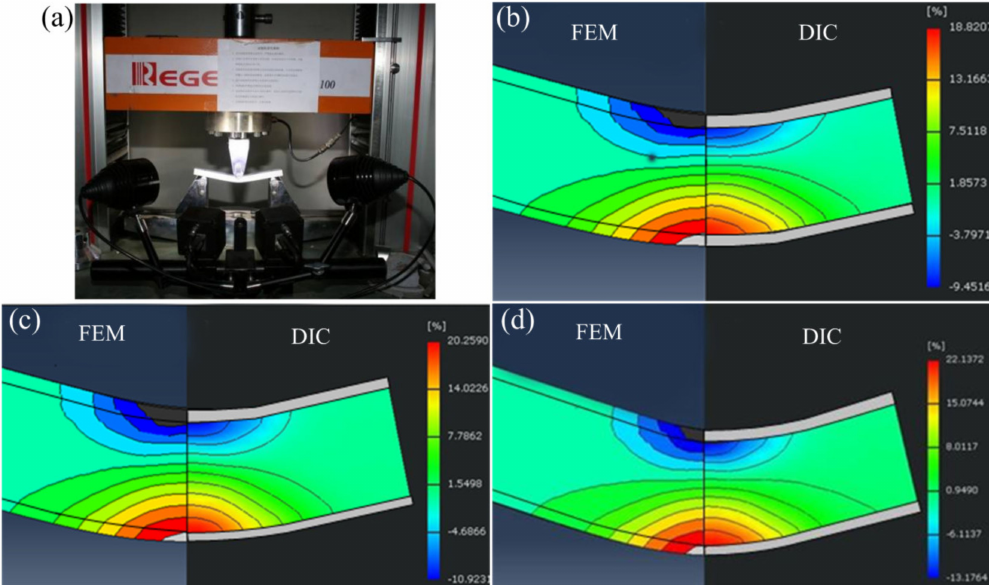
Figure 5. Digital image correlation (DIC) test and the results compared with the FE simulation results: ( a ) DIC testing equipment and process, ( b ) DIC and finite element method (FEM) results with 20-mm press amount, ( c ) DIC and FEM results with 21-mm press amount, and ( d ) DIC and FEM results with 22-mm press amount. Table 3. DIC and FEM results of the springback and bending angle. Press Amount /